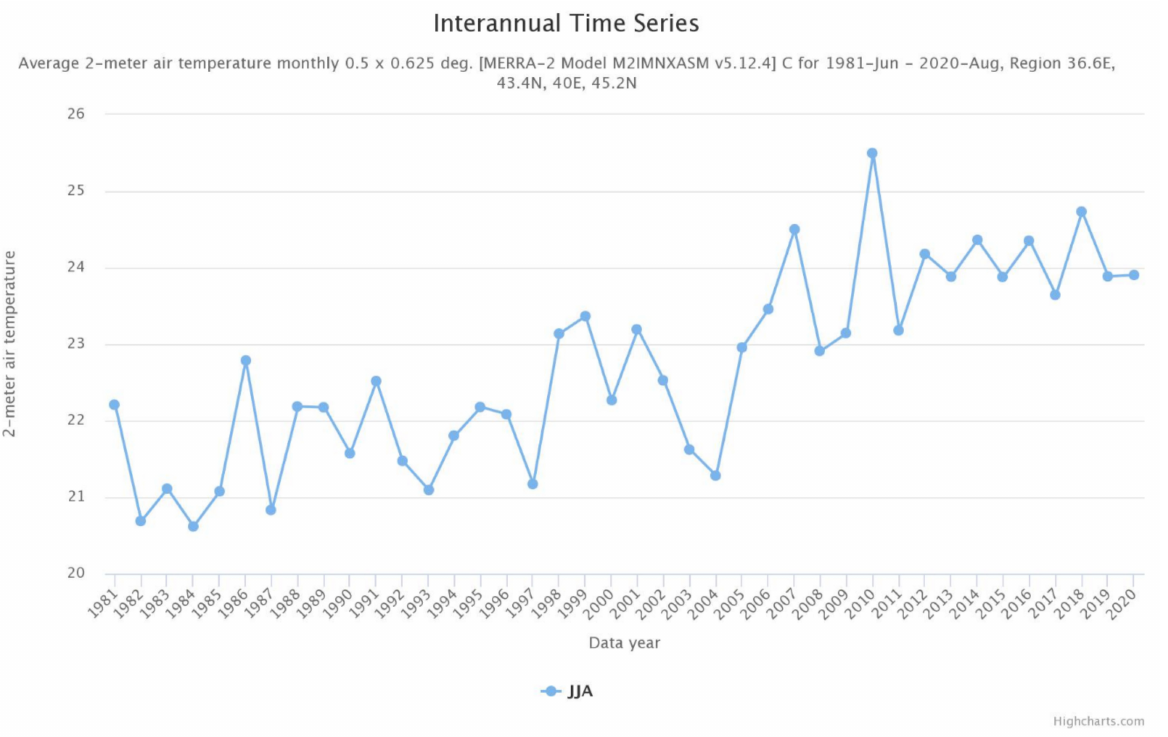
Figure 2. Interannual variability of the near-surface air temperature over the northeastern Black Sea during summer from 1981–2020 based on the MERRA-2 M2IMNXASM_5.12.4